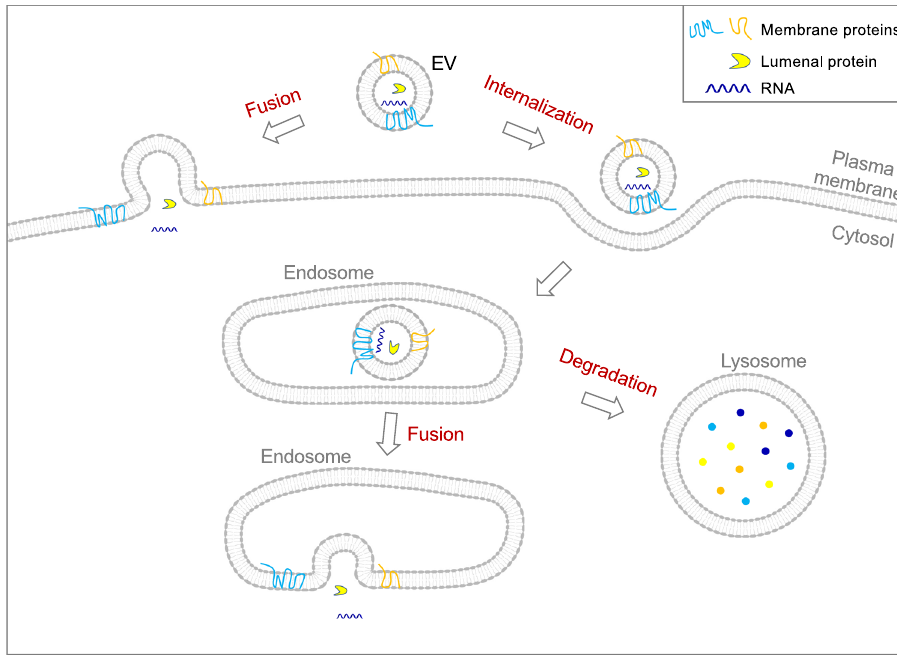
Fig. 1 Fates of EV-carried cargoes in a recipient cell. In addition to the well-documented fate of lysosomal degradation, it has been proposed that EVs can fuse with the plasma membrane or the endosome following internalization, delivering cargoes to the cytosol of the recipient